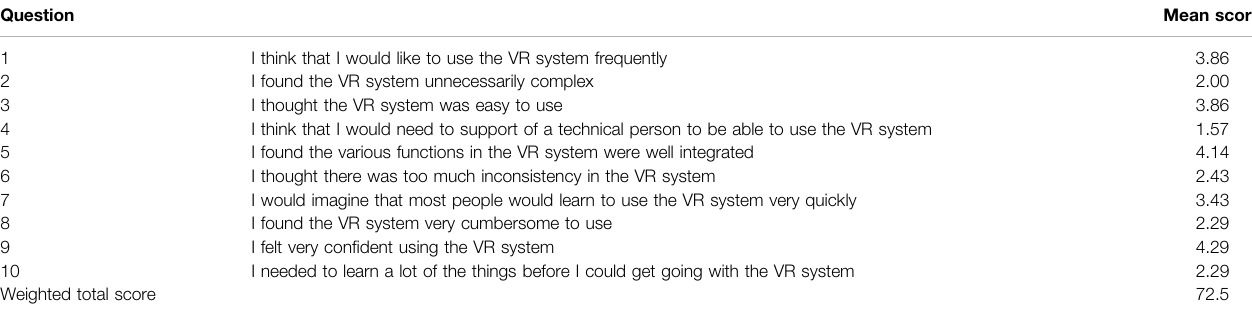
TABLE 1 | SUS Results for VR System (Oculus Go